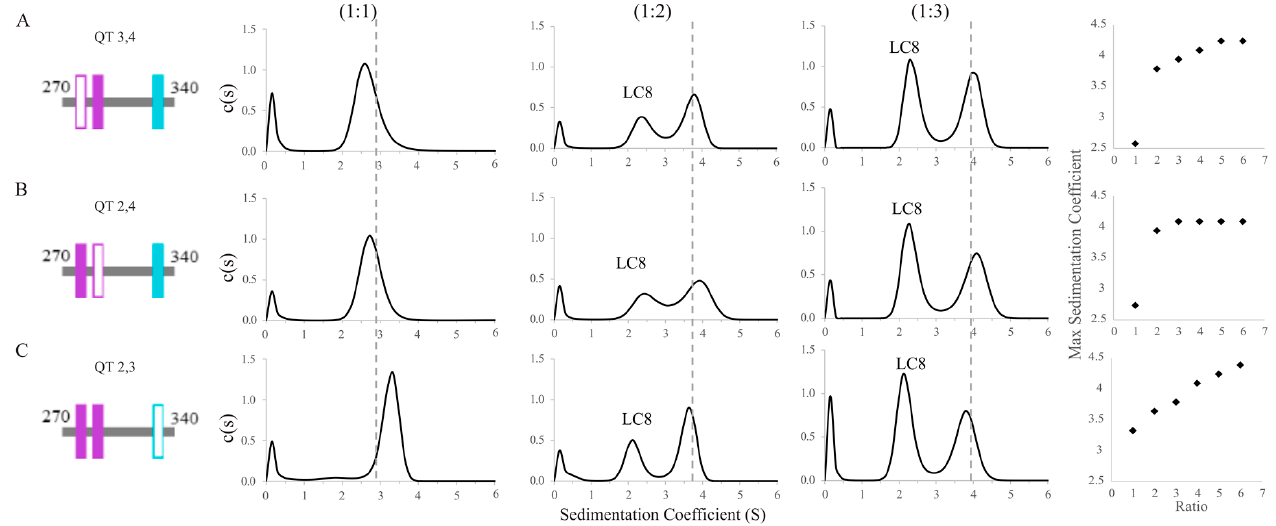
Figure 4. Sedimentation velocity analytical ultracentrifugation of double site ASCIZ constructs bound to LC8. SV-AUC titrations of QT3,4 ( A ), QT2,4 ( B ), and QT2,3 ( C ) with LC8 at three separate molar ratios of QT:LC8 (1:1, 1:2, 1:3) and a plot of LC8:QT ratio vs. complex sedimentation coefficient up to a ratio of 1:6. When applicable, populations corresponding to free LC8 are labeled. The dashed lines correspond to the location of the peak seen in QT2–4 at the same ratio.